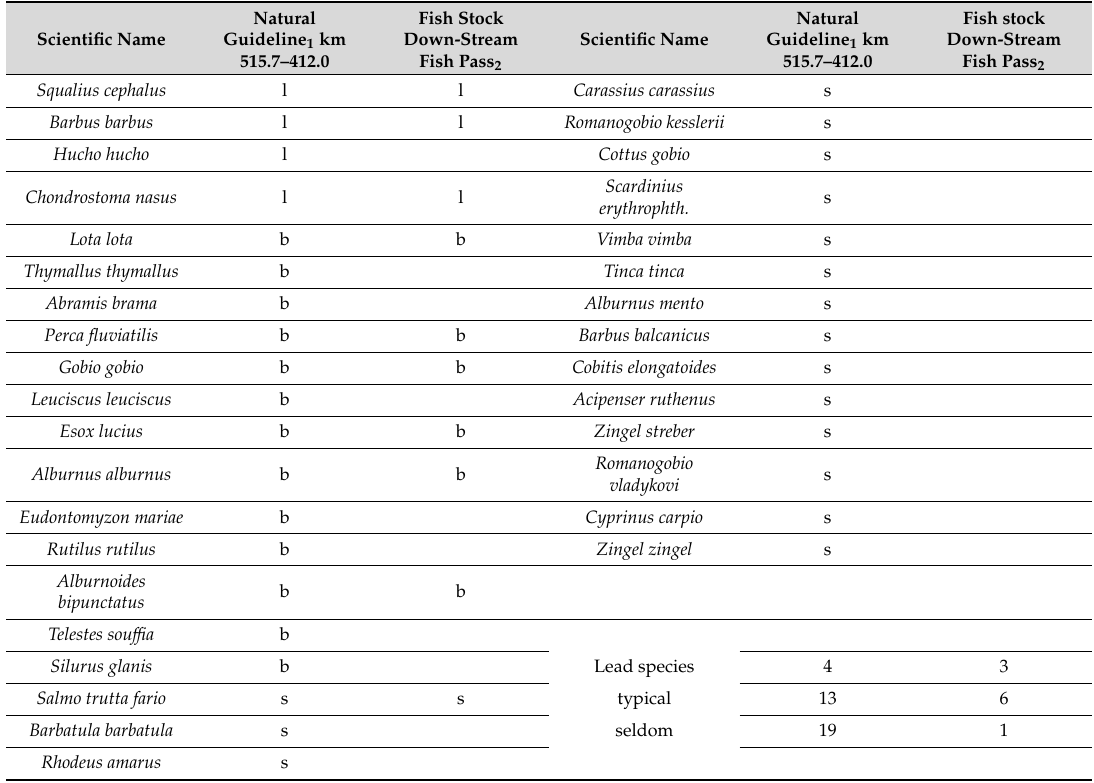
Table 1. Natural guideline and recorded fish species downstream from the weir